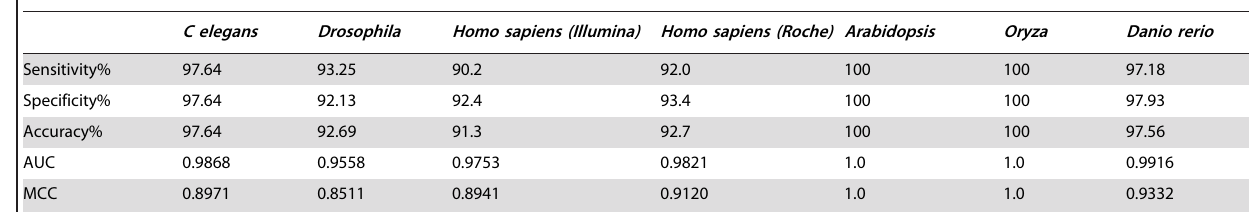
Table 2. Performance measurement.